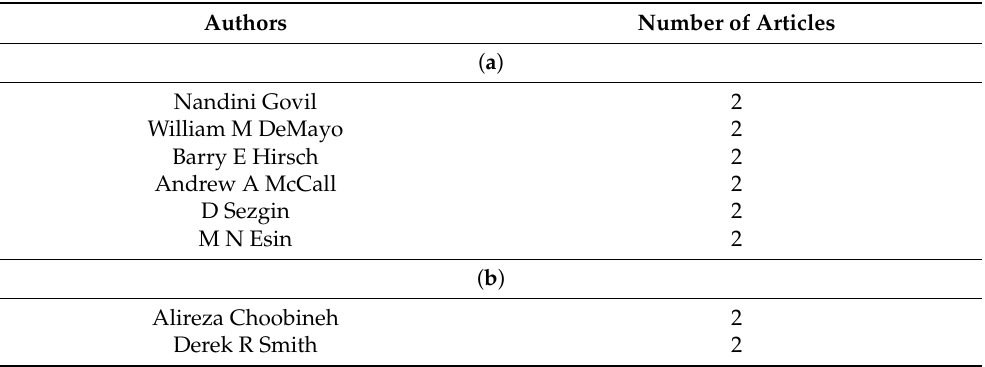
Table 6. (a): First authors of top-cited articles on WMSDs in relation to RULA. (b): First authors of top-cited articles on WMSDs in relation to